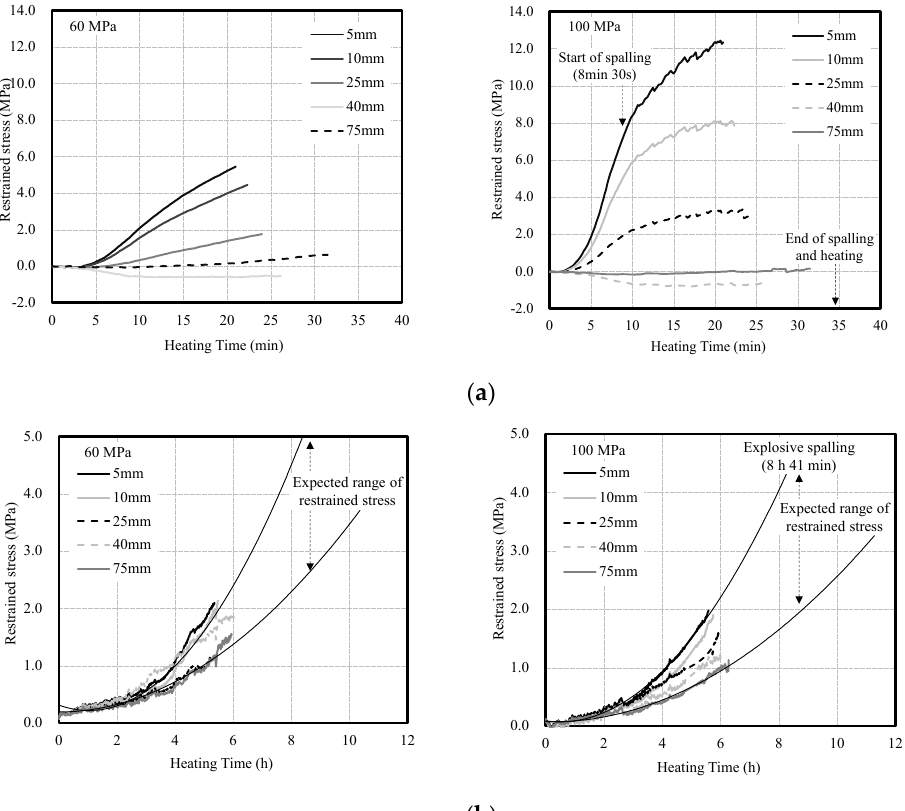
Figure 9. Restrained stress in concrete according to heating rate. ( a ) Fast heating (ISO-824). ( b ) Slow heating (1 °C/min).